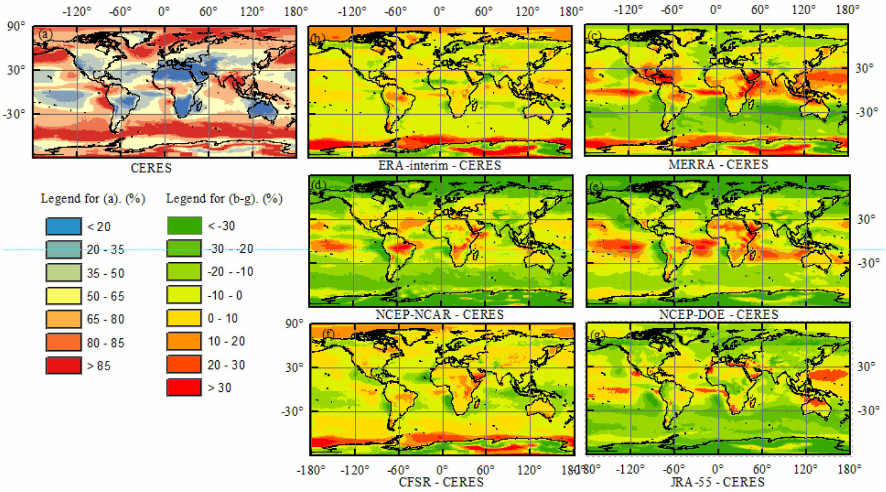
Figure 7. CERES CF climatologies for JJA and the biases between the reanalyzed CF and the CERES CF (reanalysis minus CERES) from 2001 to 2009: ( a ) CERES monthly CF for JJA; ( b ) ERA-Interim minus CERES; ( c ) MERRA minus CERES; ( d ) NCEP-NCAR minus CERES; ( e ) NCEP-DOE minus CERES; ( f ) CFSR minus CERES; ( g ) JRA-55 minus